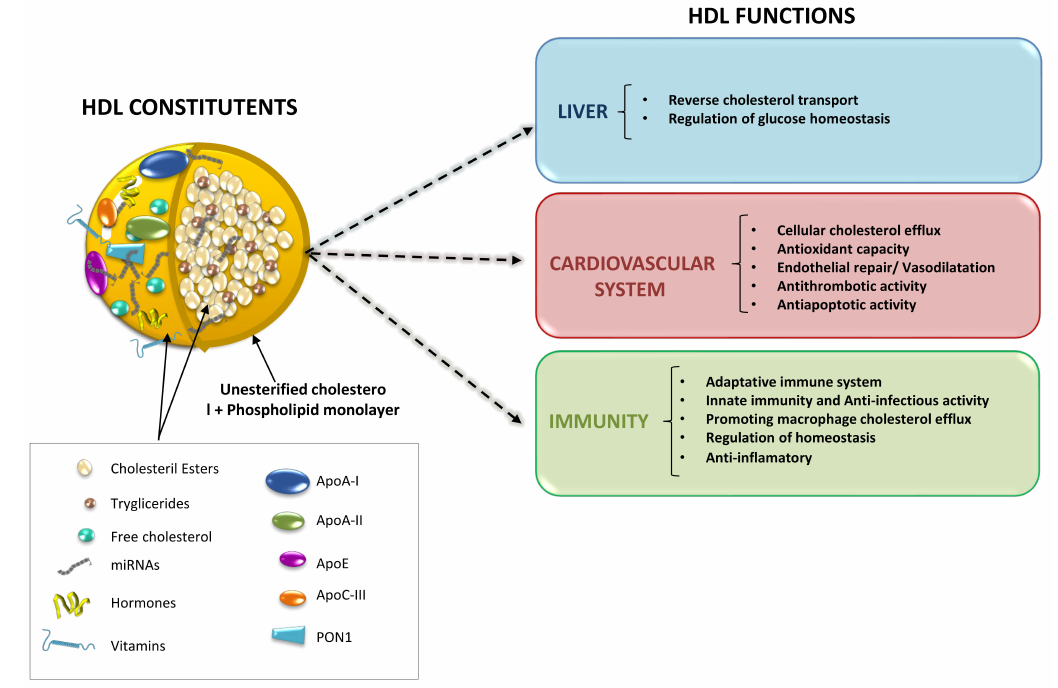
Figure 1. HDL main constituents and HDL-related functions in di ff erent cellular